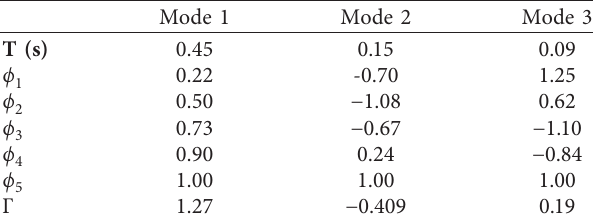
Table 2: Eigenvalue analysis